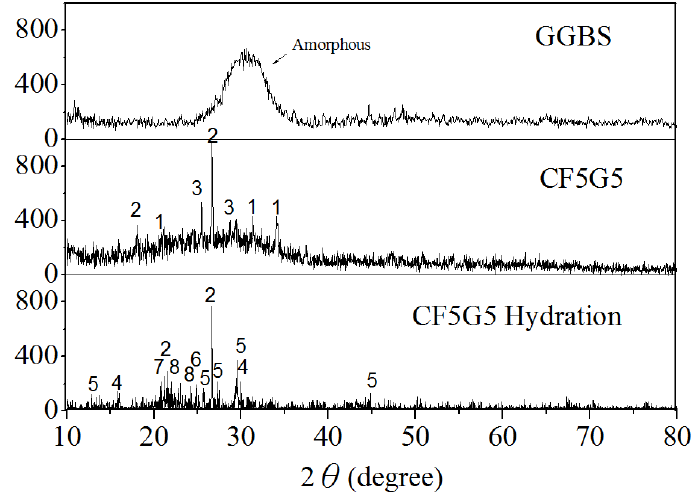
Figure 9. X-ray diffraction of GGBS, CF5G5 and CF5G5 hydration. (GGBS: ground granulated blast-furnace slag, CF5G5: 50% fly ash CF + 50%